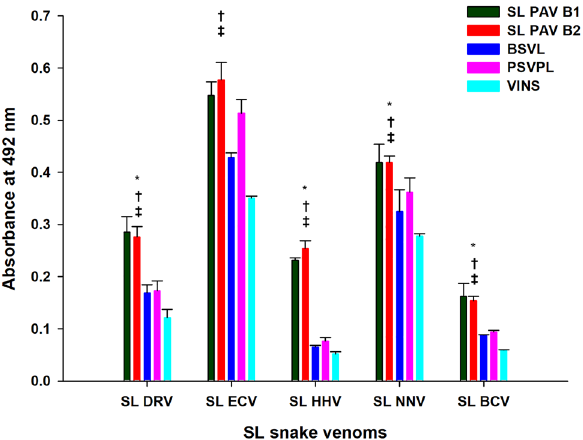
Figure 4. Determination of immunological cross-reactivity between two batches of SL PAV/Indian PAVs and SL snake venoms by ELISA. Values are mean ± SD for triplicate determinations. *Significance of difference between SL PAV B1 and B2 with respect to BSVL; † significance of difference between SL PAV B1 and B2 with respect to PSVPL; ‡ significant difference between SL PAV B1 and B2 with respect to VINS, (p <